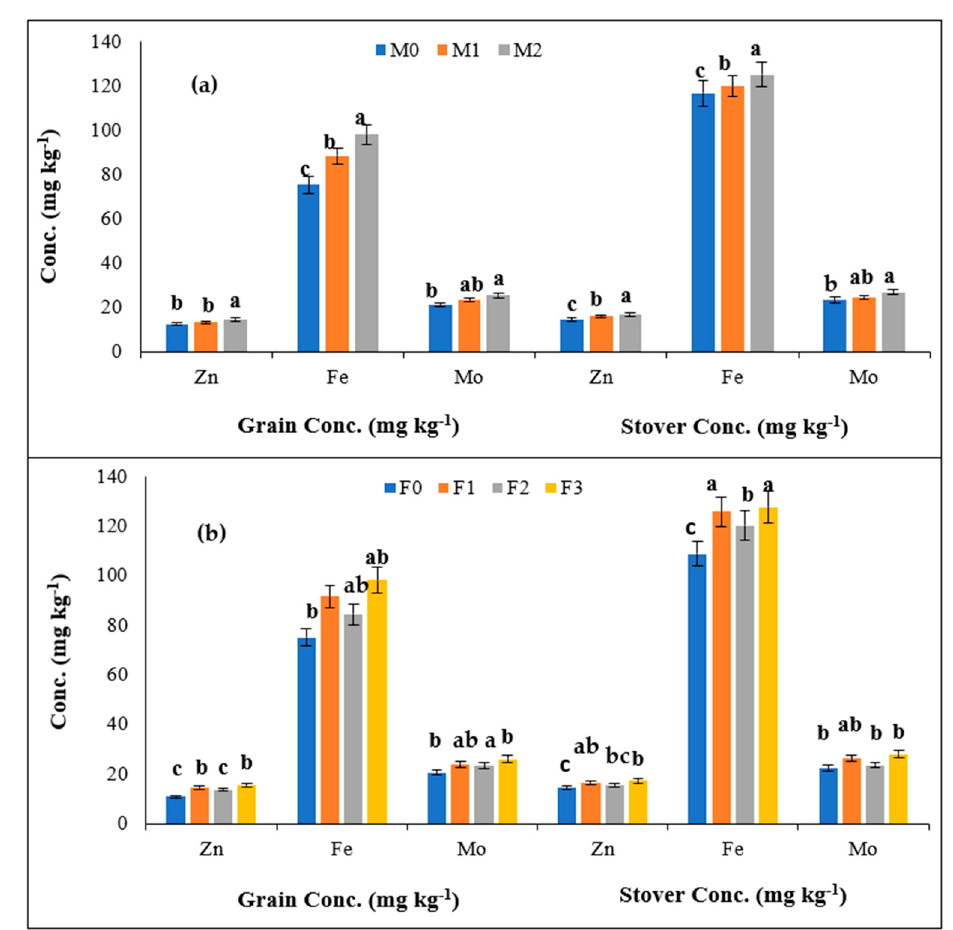
Figure 2. ( a ) Effect of different methods of Mo, ( b ): Fe and Zn application on Zn, Fe and Mo concentrations in the grain and stover of cowpea. Column representing the mean with a similar or dissimilar letter(s) was evaluated with the least significant difference (LSD) multiple range tests using a probability level of p ≤ 0.05 along with standard deviation.